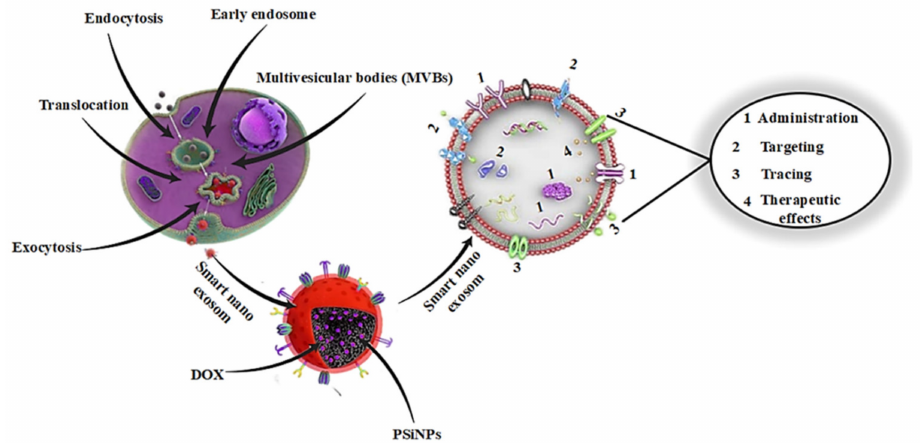
Figure 1. Background of smart